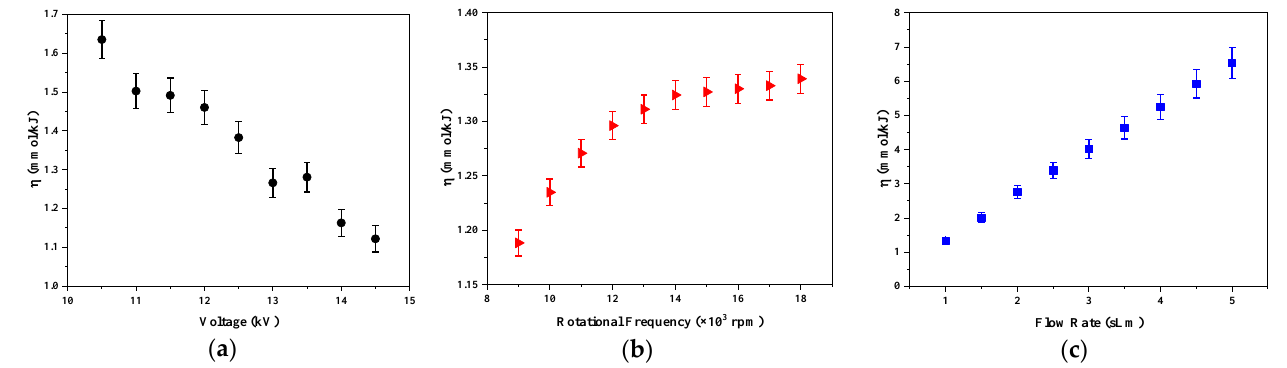
Figure 5. The energy efficiency of hydrogen production versus ( a ) different voltages applied on the stationary power electrode at 1 sLm gas flow rate, ( b ) rotational frequencies of power electrode at 14 kV applied voltage and 1 sLm gas flow rate, and ( c ) gas flow rates at 14 kV applied voltage and 18,000 rpm rotational frequency of power electrode.